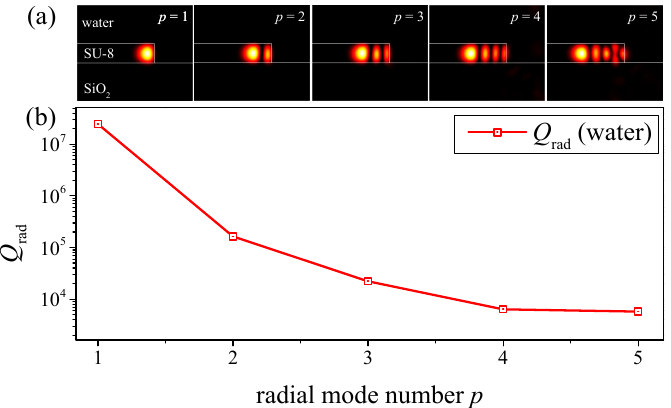
Figure 3. ( a ) The field distributions for different radial mode numbers. ( b ) Calculated radiation-loss- related Q rad for different radial mode